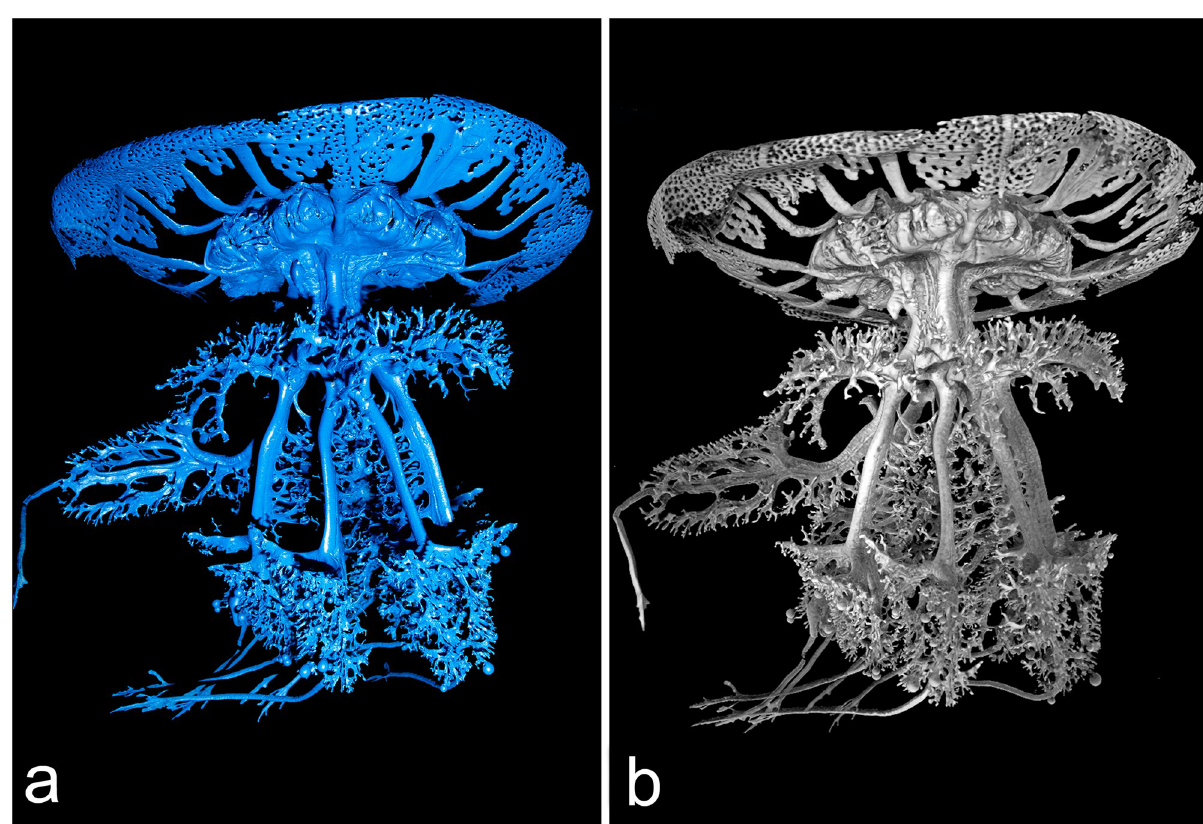
Fig 1. Rhizostoma pulmo gastrovascular system of the manubrium. (a) Resin endocast of the whole gastrovascular system of a specimen of 14.6 cm in diameter. (b) 3D rendering obtained by X-ray microtomographic data of the resin endocast showed in (a). Tomographic reconstruction performed with an isotropic voxel size of 62.0 μ